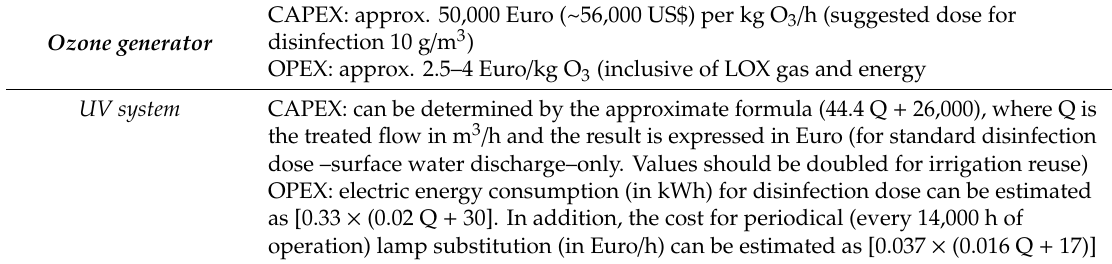
Table 9. Investment and operational cost of ozone and UV facilities for water treatment.